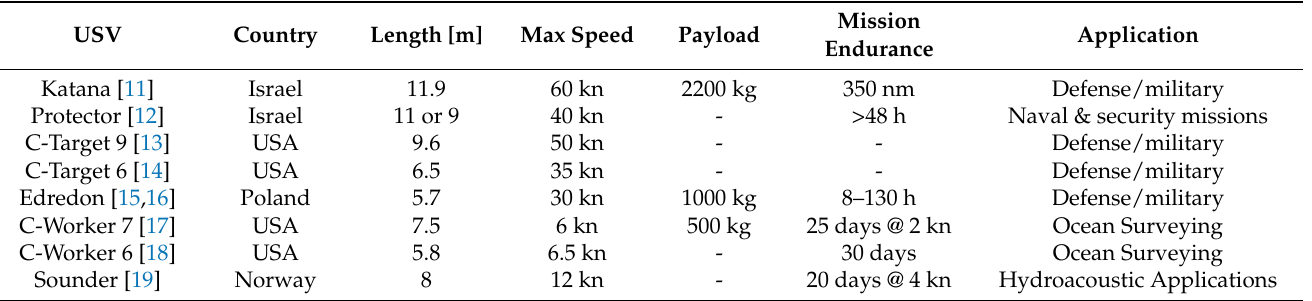
Table 2. Examples of recently developed USVs.